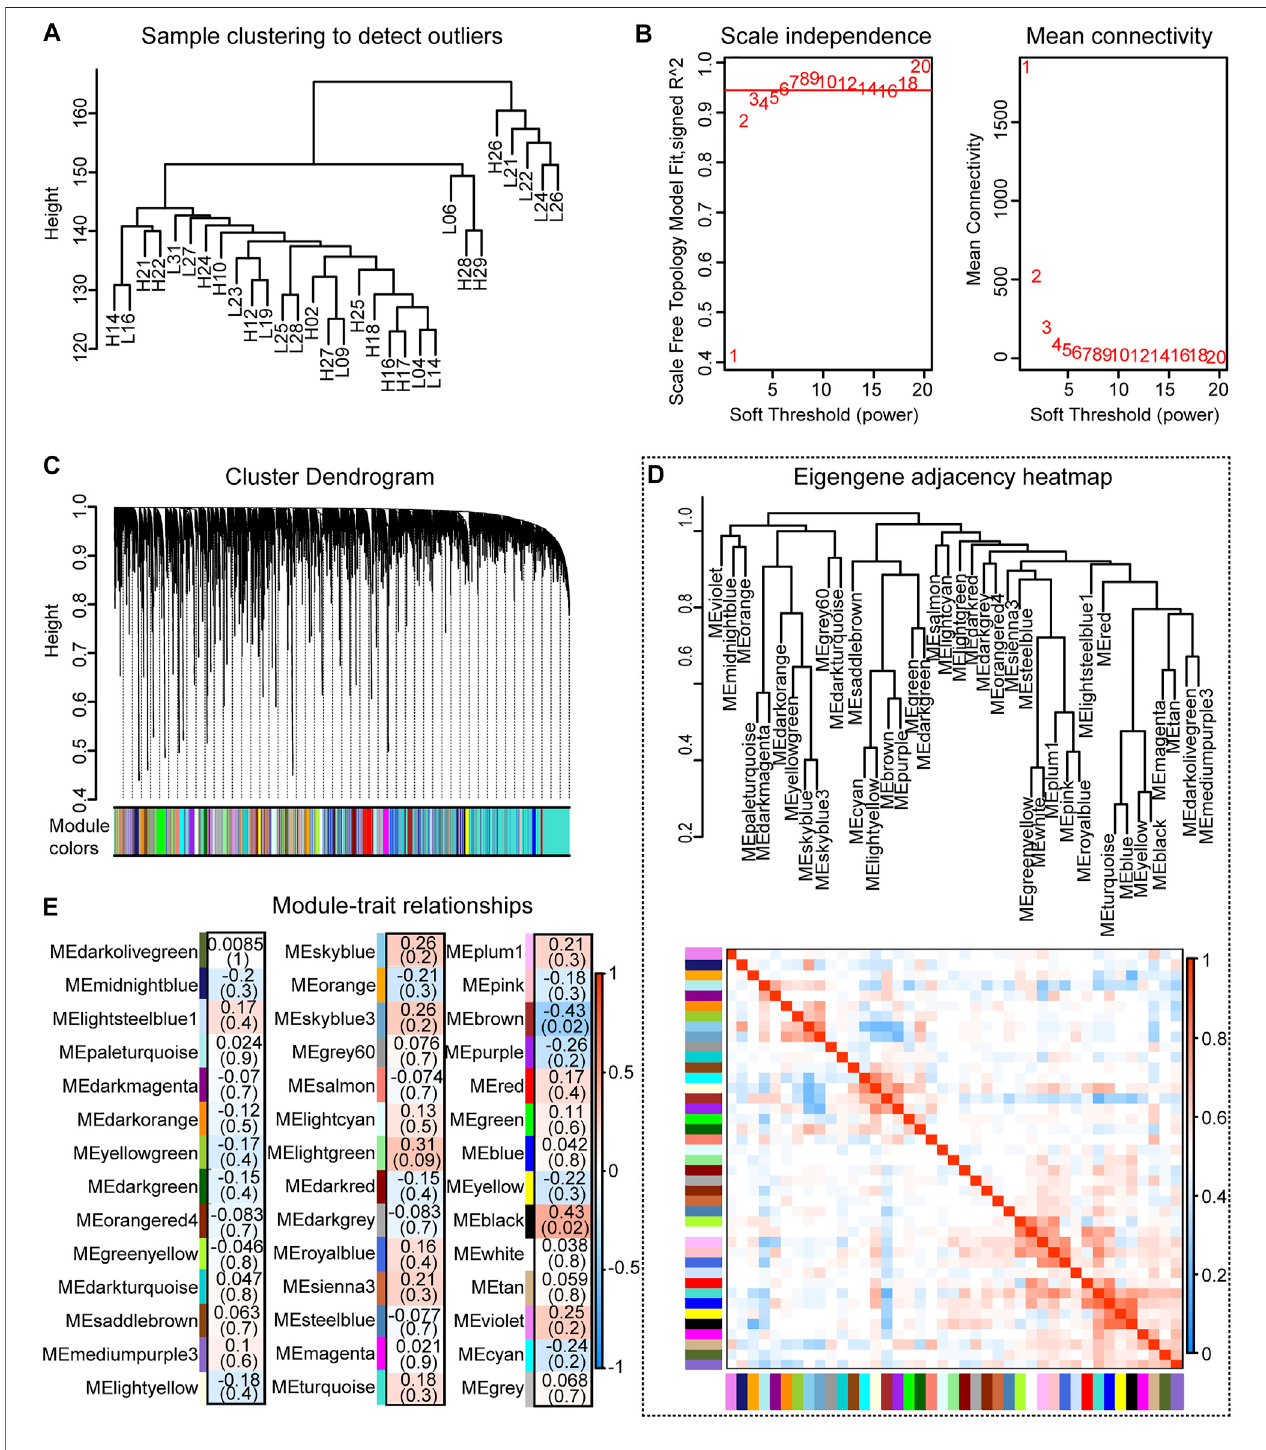
FIGURE 6 | Co-expression analysis results. (A) Clustering dendrogram of 30 samples; (B) Determination of soft threshold power in co-expression analysis; (C) Hierarchical clustering dendrogram of all modules; (D) Correlation diagram between modules; (E) Relationship between all modules and IMF traits correlation graph.